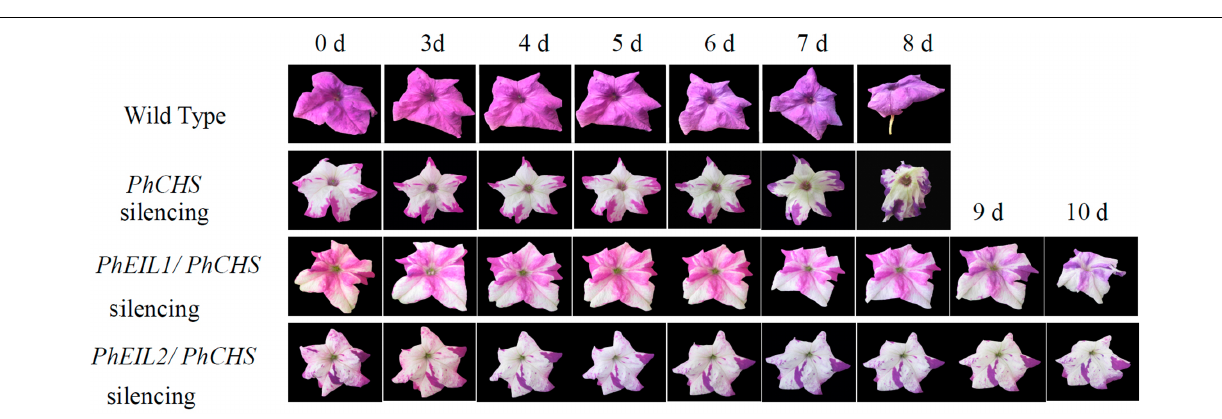
FIGURE 3 | Effects of PhCHS silencing, PhCHS/PhEIL1 silencing, and PhCHS/PhEIL2 silencing on the longevity of petunia flowers. Petunia plants were infected with TRV CHS, TRV PhCHS/PhEIL1, or TRV PhCHS/PhEIL2. Flowers showing the white silencing phenotype and purple flowers from uninfected plants were excised and photographed every day after